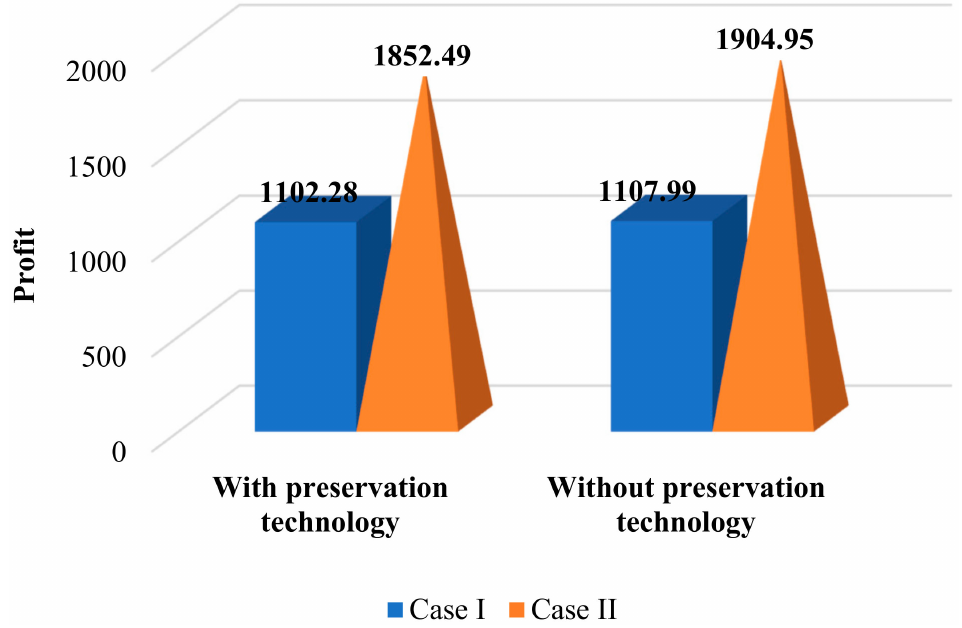
Figure 6. Comparison between the models with advance payment and without advance payment.